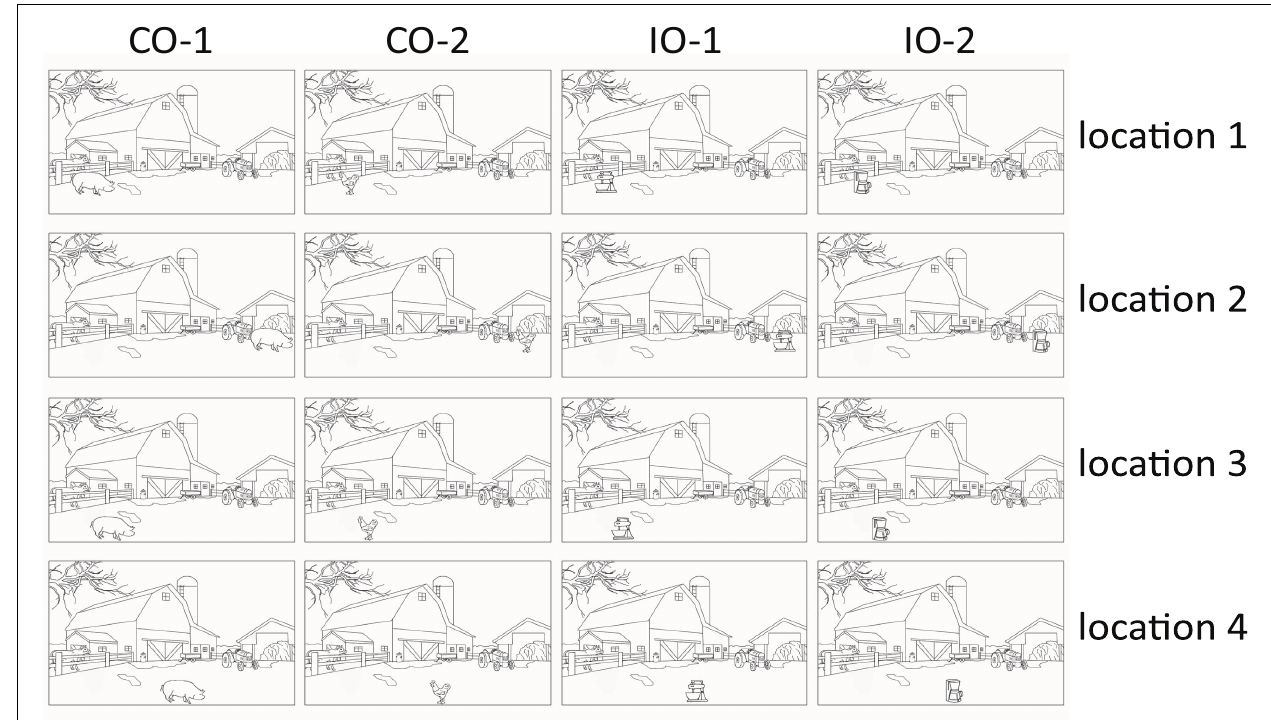
FIGURE 1 | Illustration of stimuli used in Experiments 1 and 2. Depicted is one scene, and how it was presented with objects in different locations (in different rows). Each scene was shown with two objects of the consistent type (CO-1 and CO-2, 1st and 2nd column) and two of the inconsistent type (IO-1 and IO-2, 1st and 2nd columns). The scene represents a farm, with the objects in the lower left corner of the image. Consistent objects are a pig and